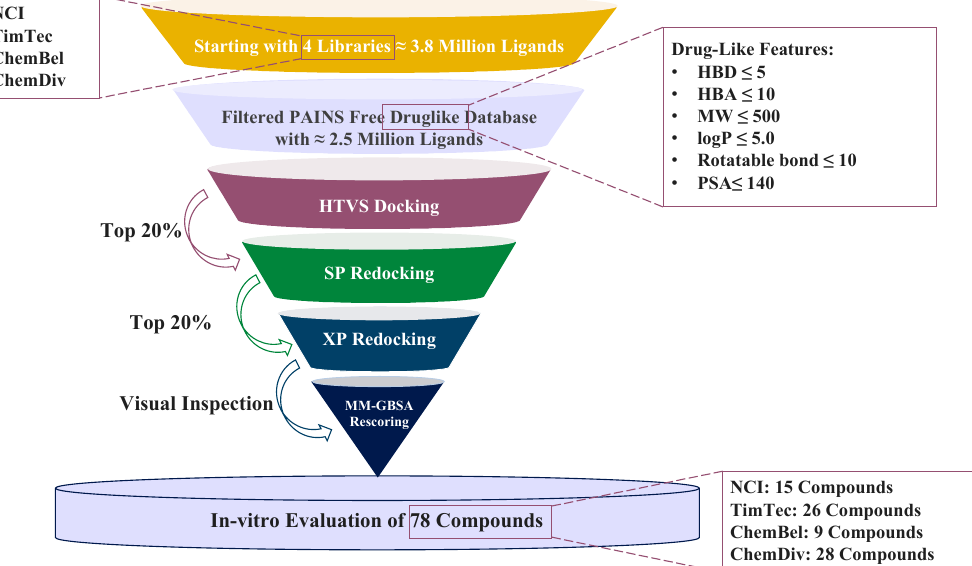
Figure 1. Docking-based virtual screening conducted against the SARS-CoV-2 M pro active site.